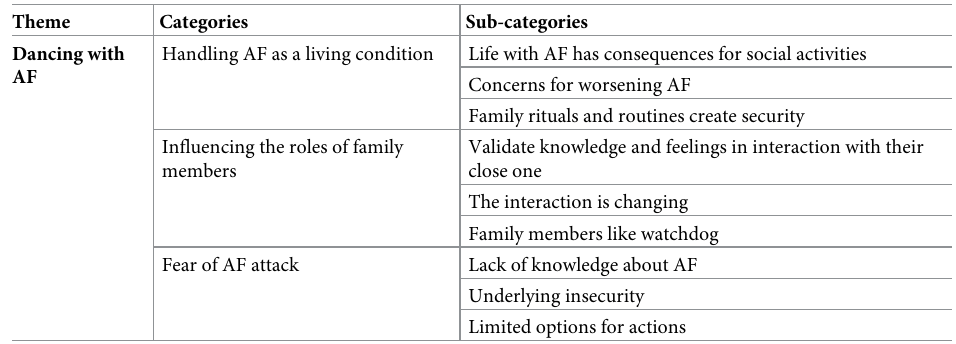
Table 3. Themes, categories, and